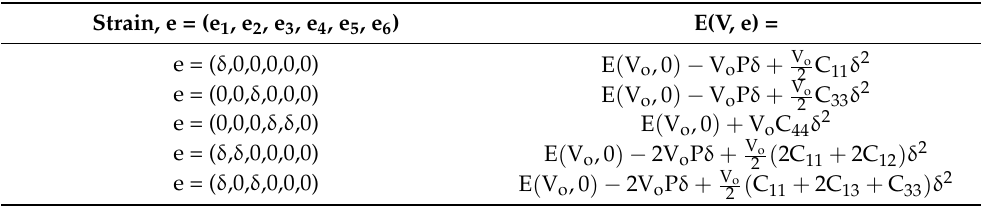
Table 1. Applied strains (in Voigt notation) and corresponding total energy expansion of sH gas hydrate under